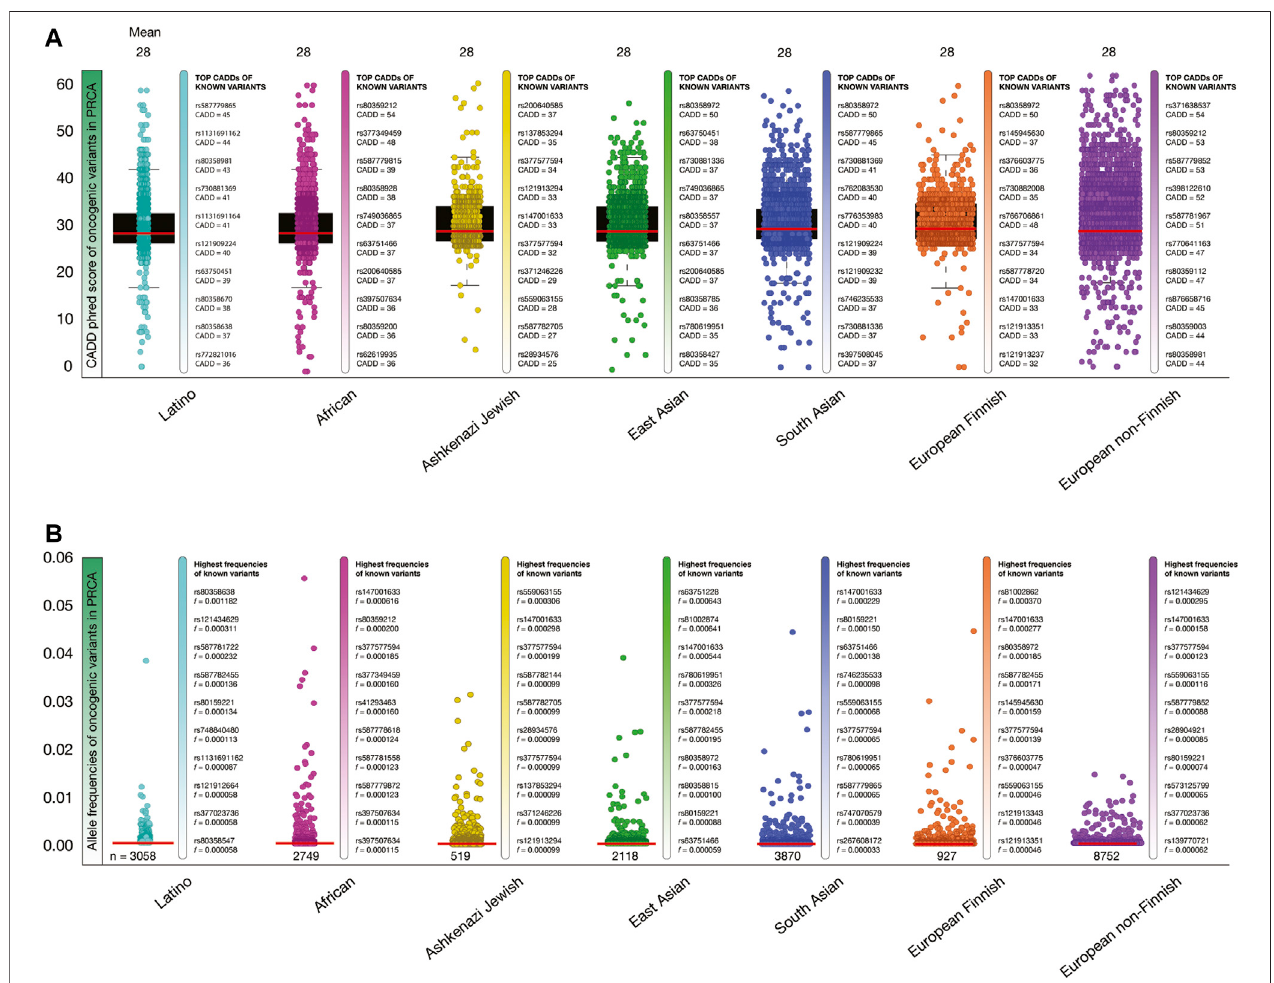
FIGURE 6 | Deleteriousness scores and allele frequencies of PRCA oncogenic variants per human population. (A) Box plots show CADD phred scores of PRCA known and predicted oncogenic variants per human population. Vertical bars show ranking of known oncogenic variants with the highest CADD phred scores per human population. Red lines show the mean of deleteriousness scores per human population. (B) Box plots show allele frequencies of known and predicted PRCA oncogenic variants per human population. Vertical bars show ranking of known oncogenic variants with the highest allele frequencies per human population. Red lines show the mean of deleteriousness scores per human population. (C) Ranking of known oncogenic variants with the highest allele frequencies identi fi ed in prostate cancer patients from TCGA-PRCA project.